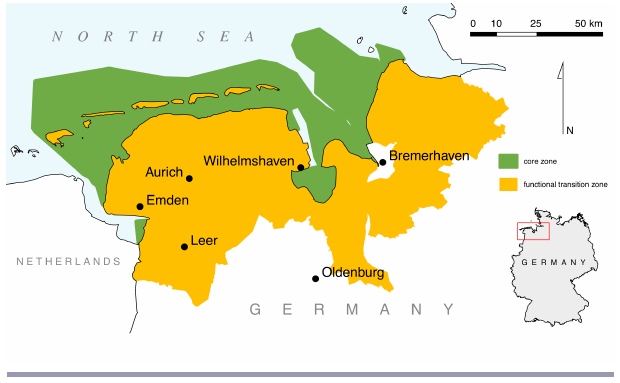
Fig. 1. Map of the East Frisian Peninsula in northwest